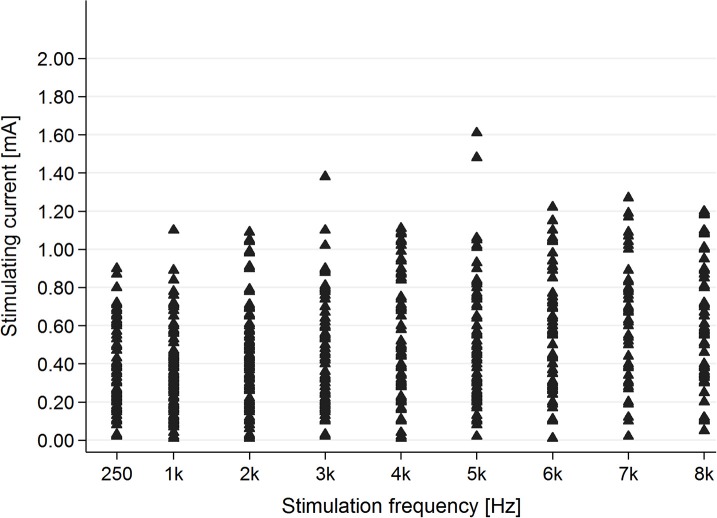
The presence of the AP in the healthy students group for particular stimulating current parameters (mA/kHz).